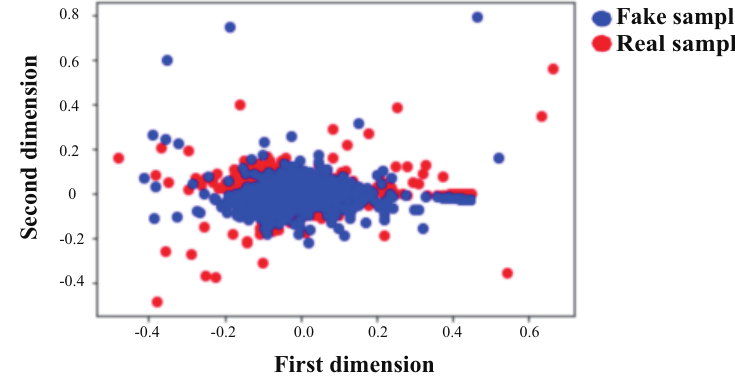
Figure 7. Feature distribution by the GAN without